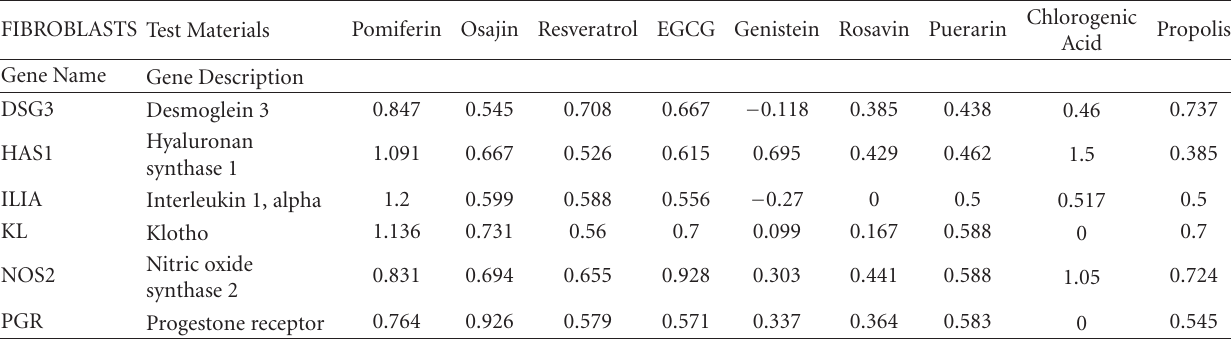
Table 4: Summary of fibroblasts genes noted to be commonly downregulated by the antioxidant treatments. FIBROBLASTS Test